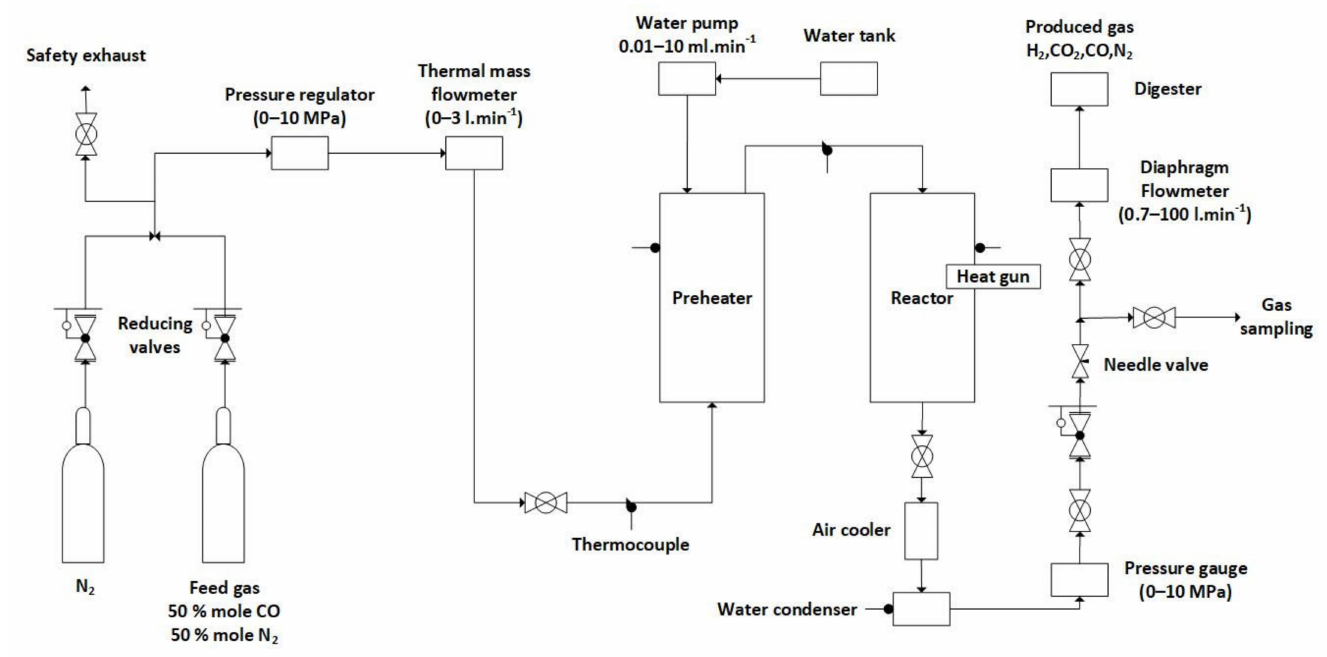
Figure 1. Scheme of the laboratory apparatus used for catalytic testing of the WGSR. The gas feed pressure ranging from 0.5 to 8 MPa was controlled using an electronic pressure regulator (Bronkhorst High-Tech BV, Ruurlo, Netherlands). The gas feed flow, up to 10 L/min (100 kPa; 25 ◦ C), measurement, and regulation were carried out using a thermal mass flow meter (Bronkhorst High-Tech BV, Ruurlo, Netherlands). To keep the pressure under control, two pressure gauges were placed before and after the regulating needle valve. At individual sections of the apparatus, ball valves that enabled rapid depressurisation were placed. The flow of the feed gas was regulated with the help of the regulating needle valve located at the end. The gas flow produced that exited the apparatus was controlled by a G4 diaphragm flow meter supplied by the company